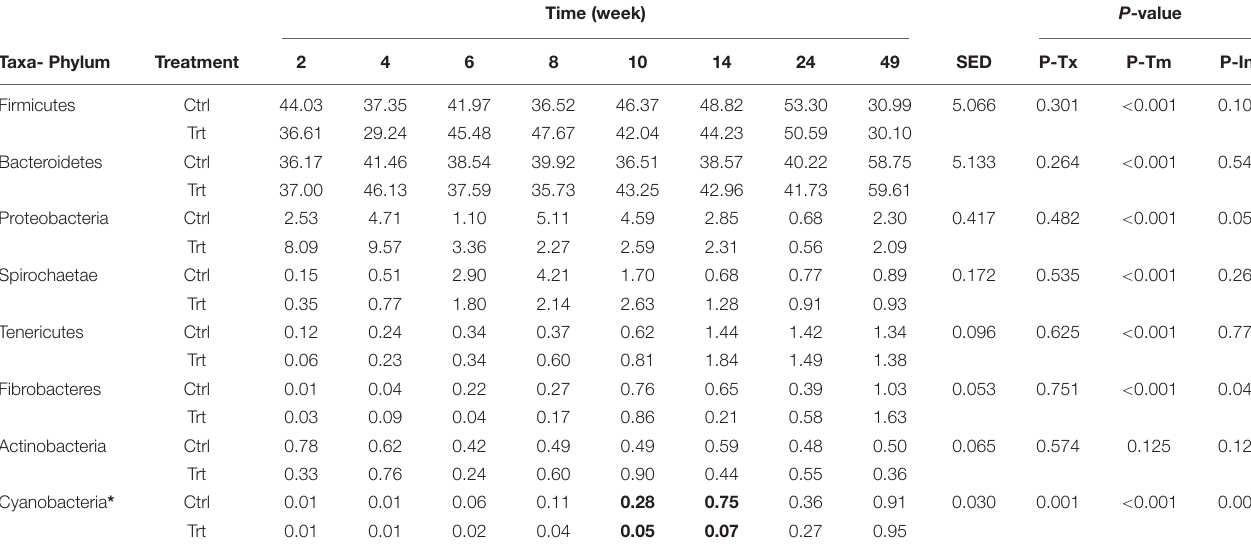
Calves were arranged in a control (Ctrl) and treatment (Trt) group. Results 4 are natural log back transformed means and standard error of the differences (SED), P-value for treatment (P-Tx), time (P-Tm) and interaction (P-Int). Significance of pairwise comparisons (Benjamini–Hochberg test) between treatments are shown in bold at each sampling time. 1 Chloroform (CF) and 9,10-anthraquinone (AQ) were applied to the concentrate and partial mixed ration diet (PMR) until week 12. 2 Abundant bacterial phyla were defined as organisms with an average proportion ≥ 0.05%. 3 Sampling times were from 2 to 49 weeks. Calves during the rearing time were fed as follows: milk twice a day and ad libitum control and treatment concentrates at weeks 2 and 4; milk once a day and ad libitum control and treatment concentrates and PMR diet at weeks 6, 8 and 10; concentrates step-down weaned and PMR diets fed ad libitum until week 14; and grazing a mixed sward of ryegrass/clover as one mob at weeks 24 and 49. 4 A repeated measurement analysis was carried out to determine the effect of methane inhibitors on the bacteria community structure at the phylum level and their carry-over effects. *Environmental bacterial